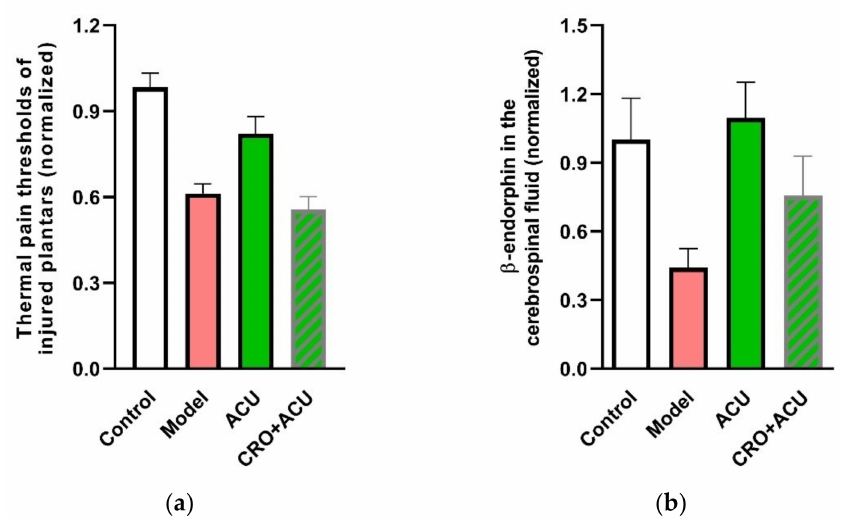
Figure 6. Contribution of MC degranulation to acupuncture analgesia ( a ) and β -endorphin increase in the cerebrospinal fluid. ( b ) Pre-injection of CRO (0.02 g/mL, 20 µ L). Establishing of inflammation pain and acupuncture intervention was referred to in the legend of Figure 5. β -endorphin in the cere- brospinal fluid was determined with enzyme linked immunosorbent assay (ELISA). Data represent means + SEM ( n = 7–14) and are based on Huang et al. (2018)